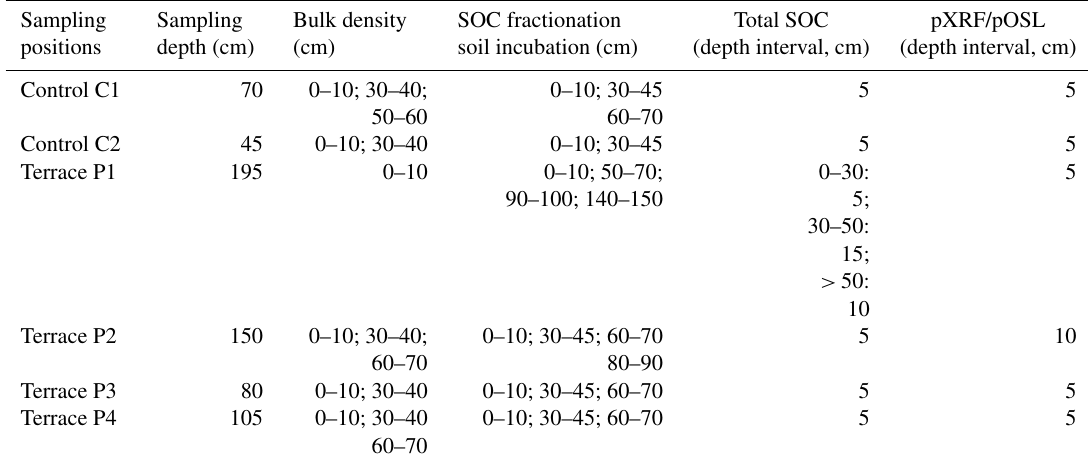
Table 1. Depth layers selected for soil analysis from sampled